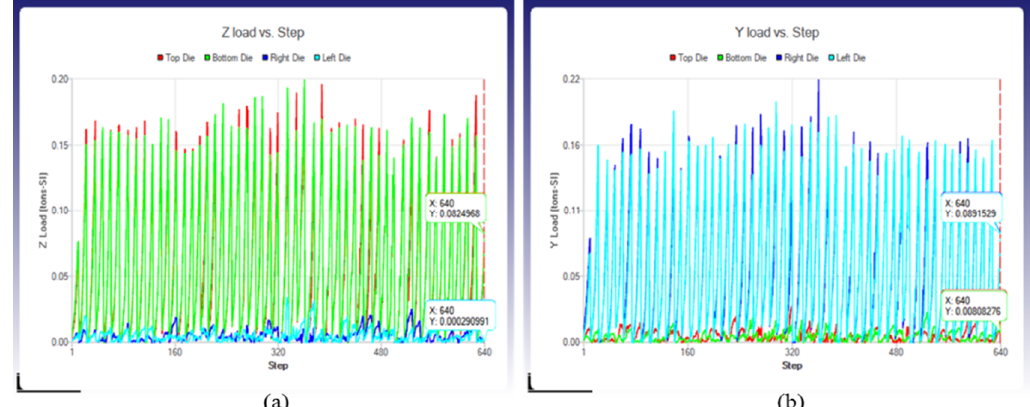
Figure 6. The load applied on the rod ( a ) along the Z direction, and ( b ) along the Y direction.